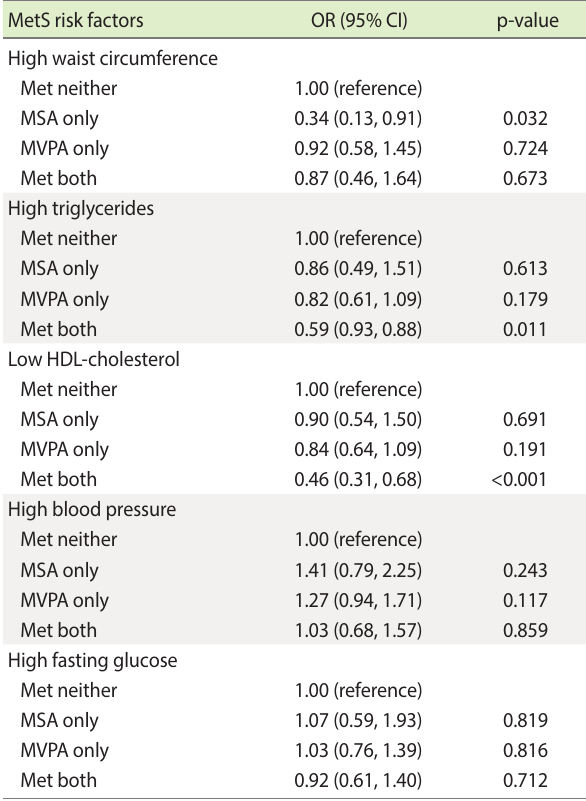
Table 2. Adherence rate to physical activity guidelines according to